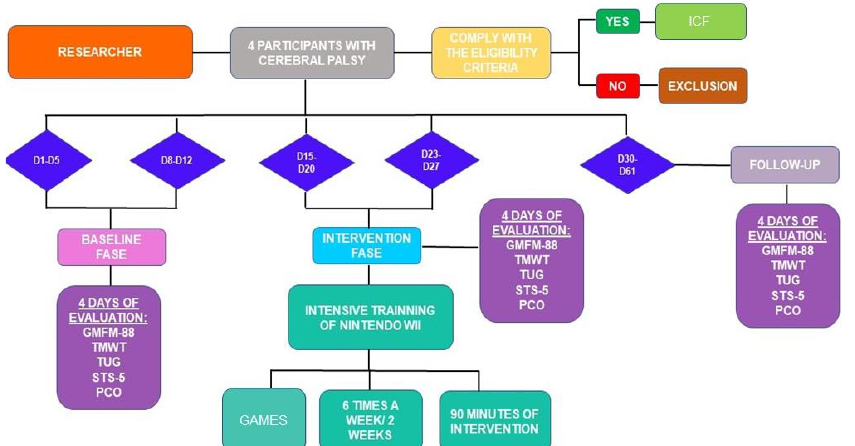
Figure 1. Study flowchart . Legend: Gross Motor Function Measure (GMFM-88), 10-m walk test (TMWT); Timed Up and Go (TUG); Sit to Stand Five times (STS-5); Pressure Center Oscillation (PCO); Informed Consent Form (ICF), Day 1 – Day 5 (D1 – D5); Day 8 – Day 12 (D8 – 12); Day 15 – Day 20 (D15 – 20); Day 23 – Day 27 (D23 – 27); Day 30 – Day 61 (D30 – 61).